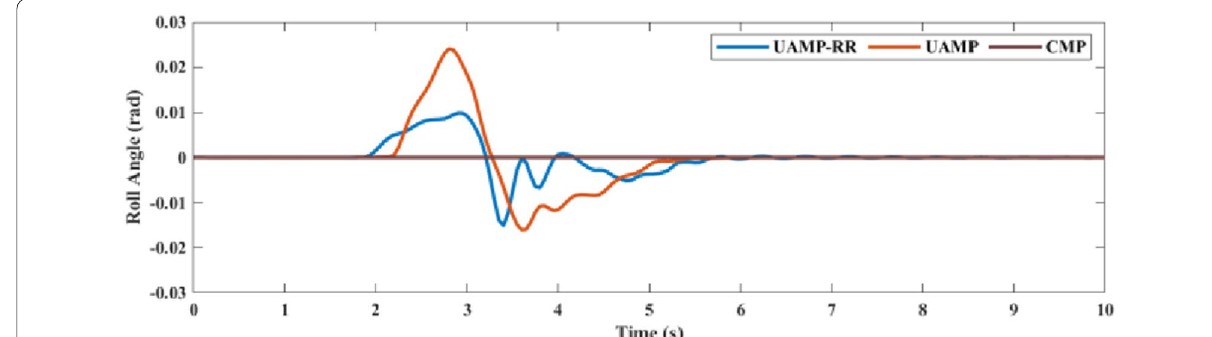
Figure 15 Roll angle of ego vehicle in case 2